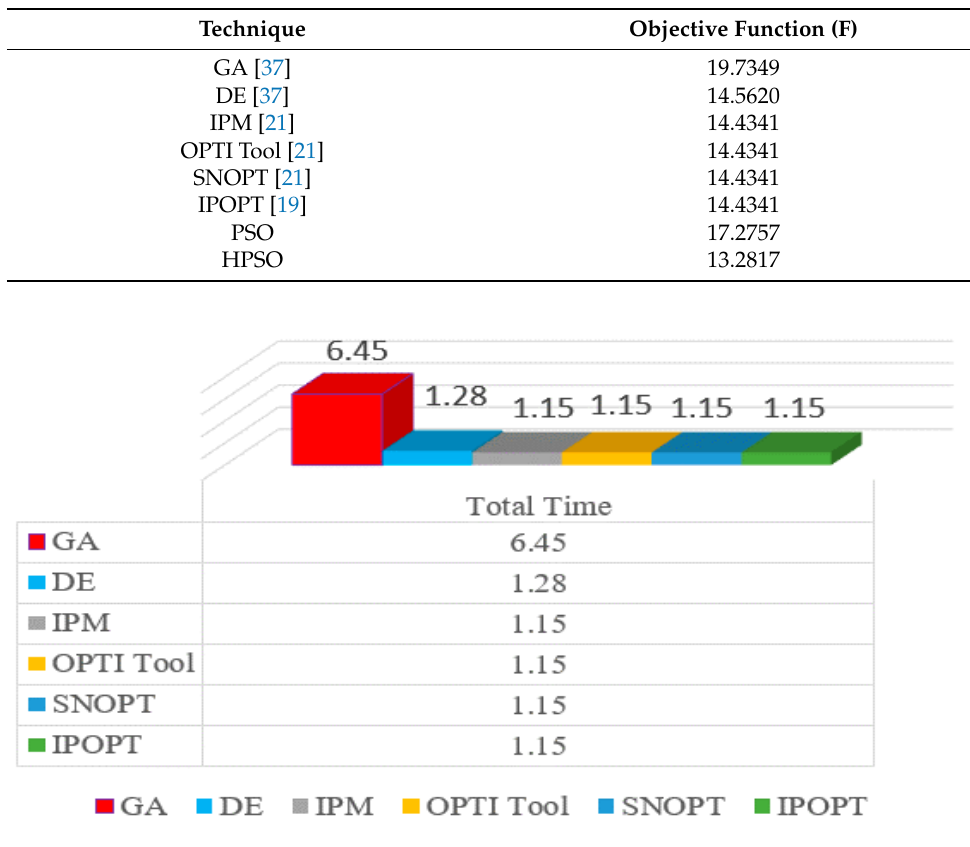
Figure 6. Analysis of net gain for the IEEE 14-Bus system.